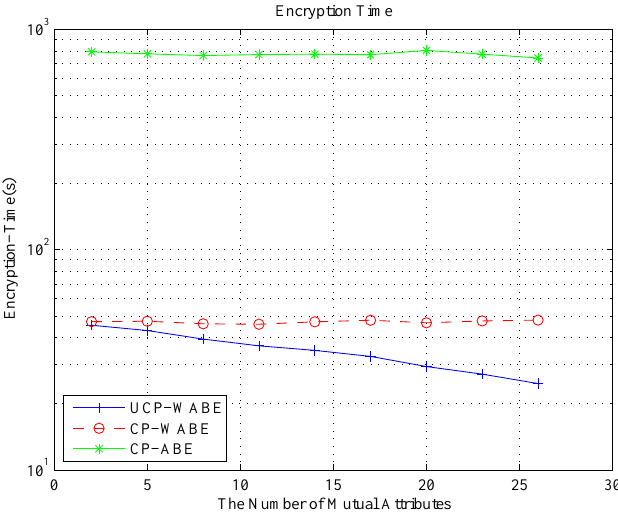
Figure 6. Encryption time cost for the changed number of mutual access tree